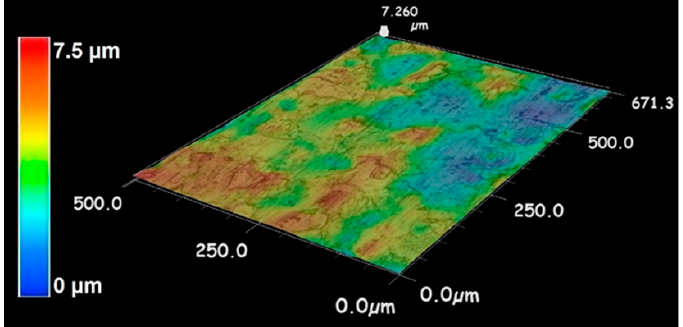
Figure 3. 3-dimensional LM image of steel alloy test plate